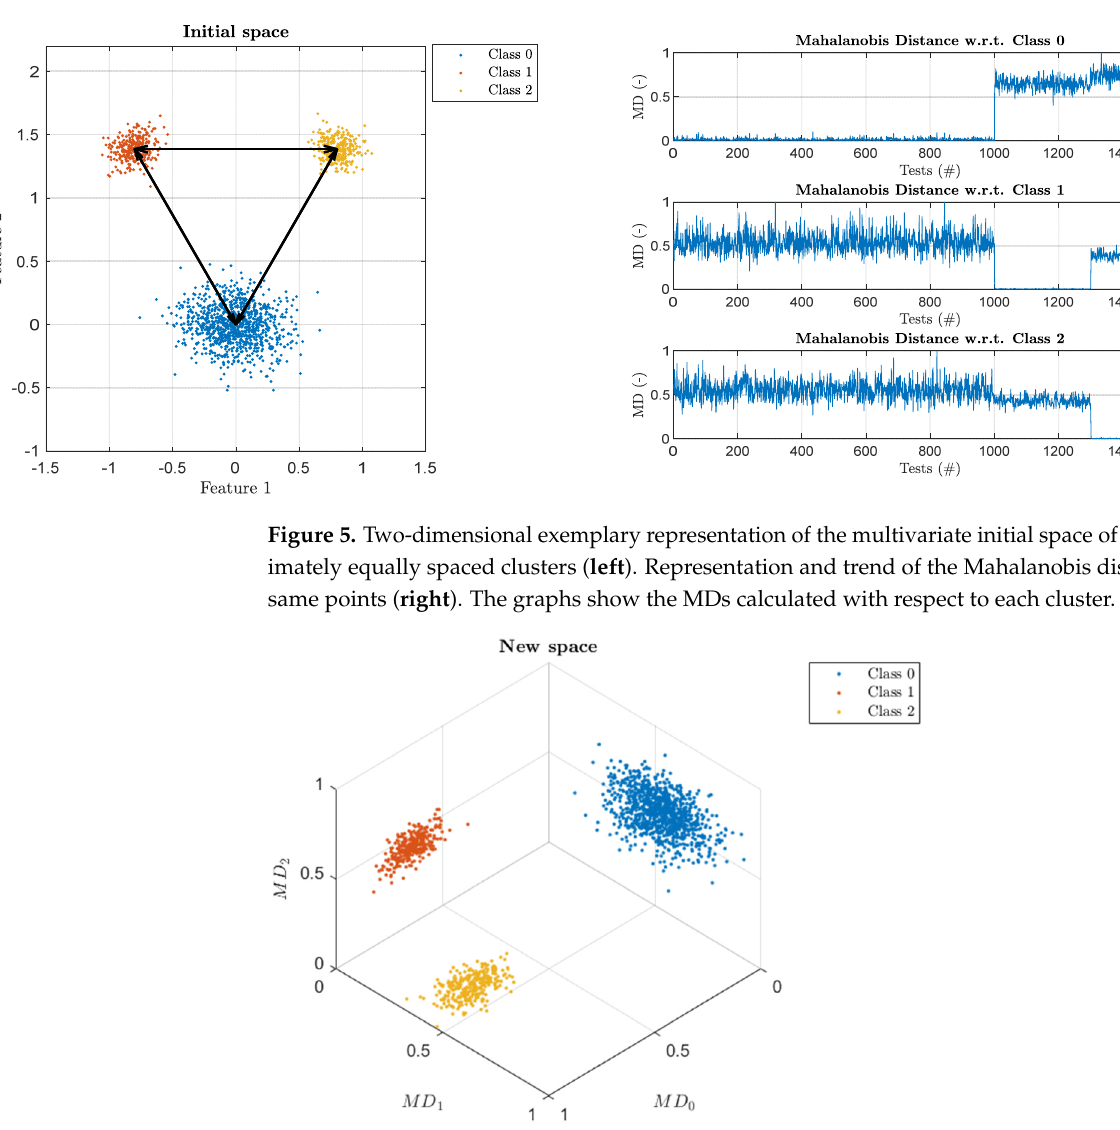
Figure 6. Representation of the new reduced space whose dimensions correspond to the MDs calculated iteratively. The clusters are well separated and distinguishable.